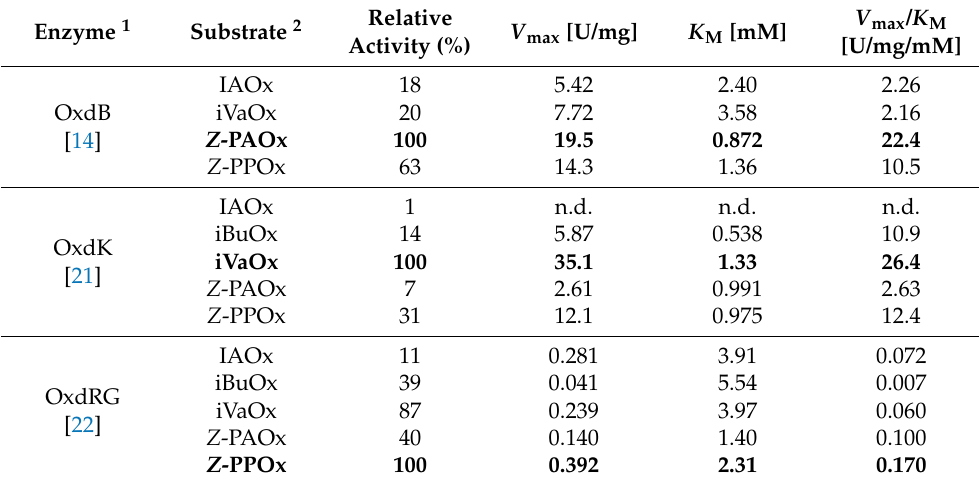
Table 2. Substrate specificities of selected bacterial aldoxime dehydratases toward plant